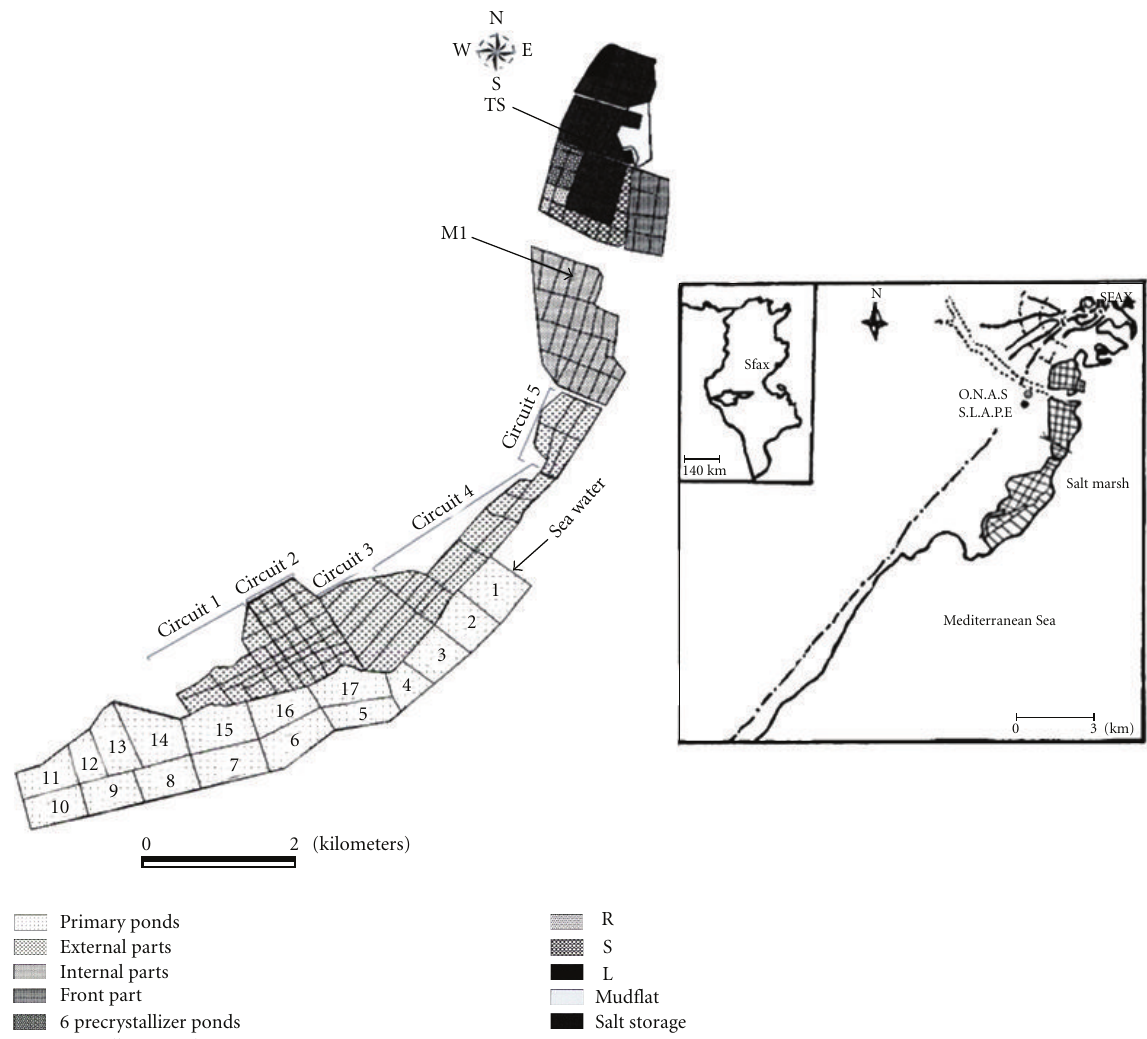
Figure 1: Map of the location of the sampling pond (TS) of the Sfax Solar Saltern in Tunisia